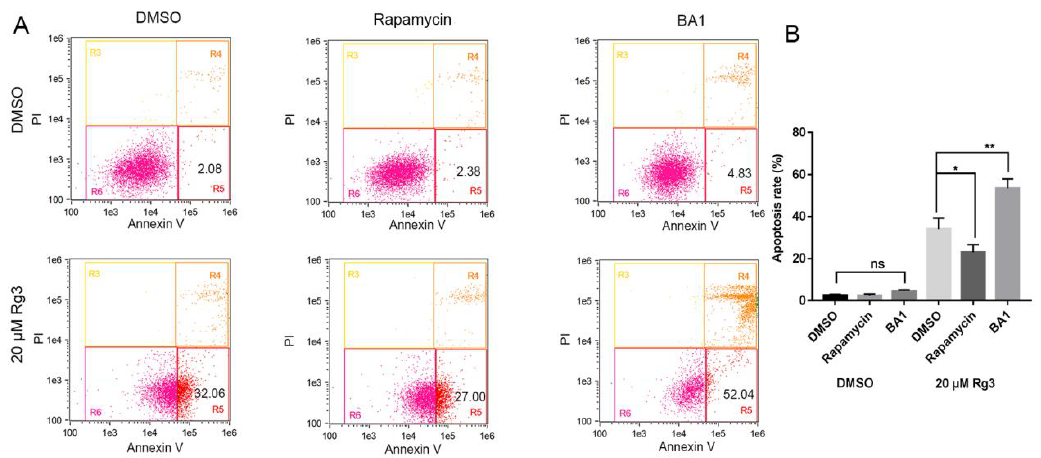
Figure 5. Apoptosis induced by 20( S )-GRg3 is associated with autophagy. ( A ) Flow cytometric analyses of apoptotic Hela cells treated with DMSO or G-Rg3 under serum-free conditions in the presence or absence of 100 nM BA1 or 100 nM rapamycin. ( B ) Statistical analysis of apoptosis determined by the flow cytometric evaluation. * p < 0.05, ** p < 0.01, ns >